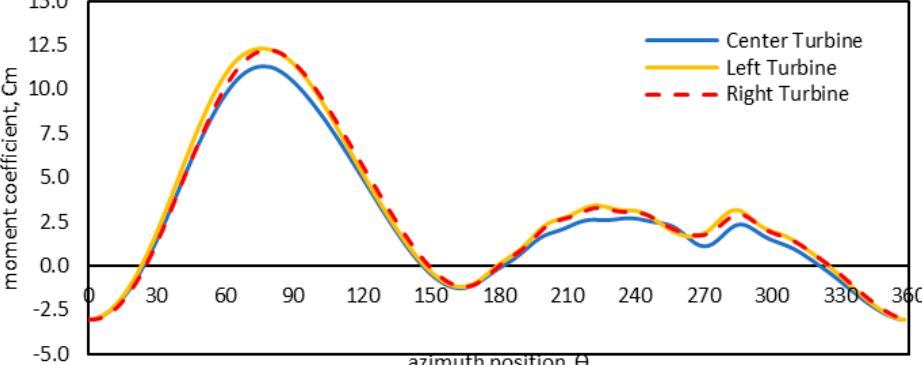
Figure 14. Torque ripple at 2 rotor distance configuration.